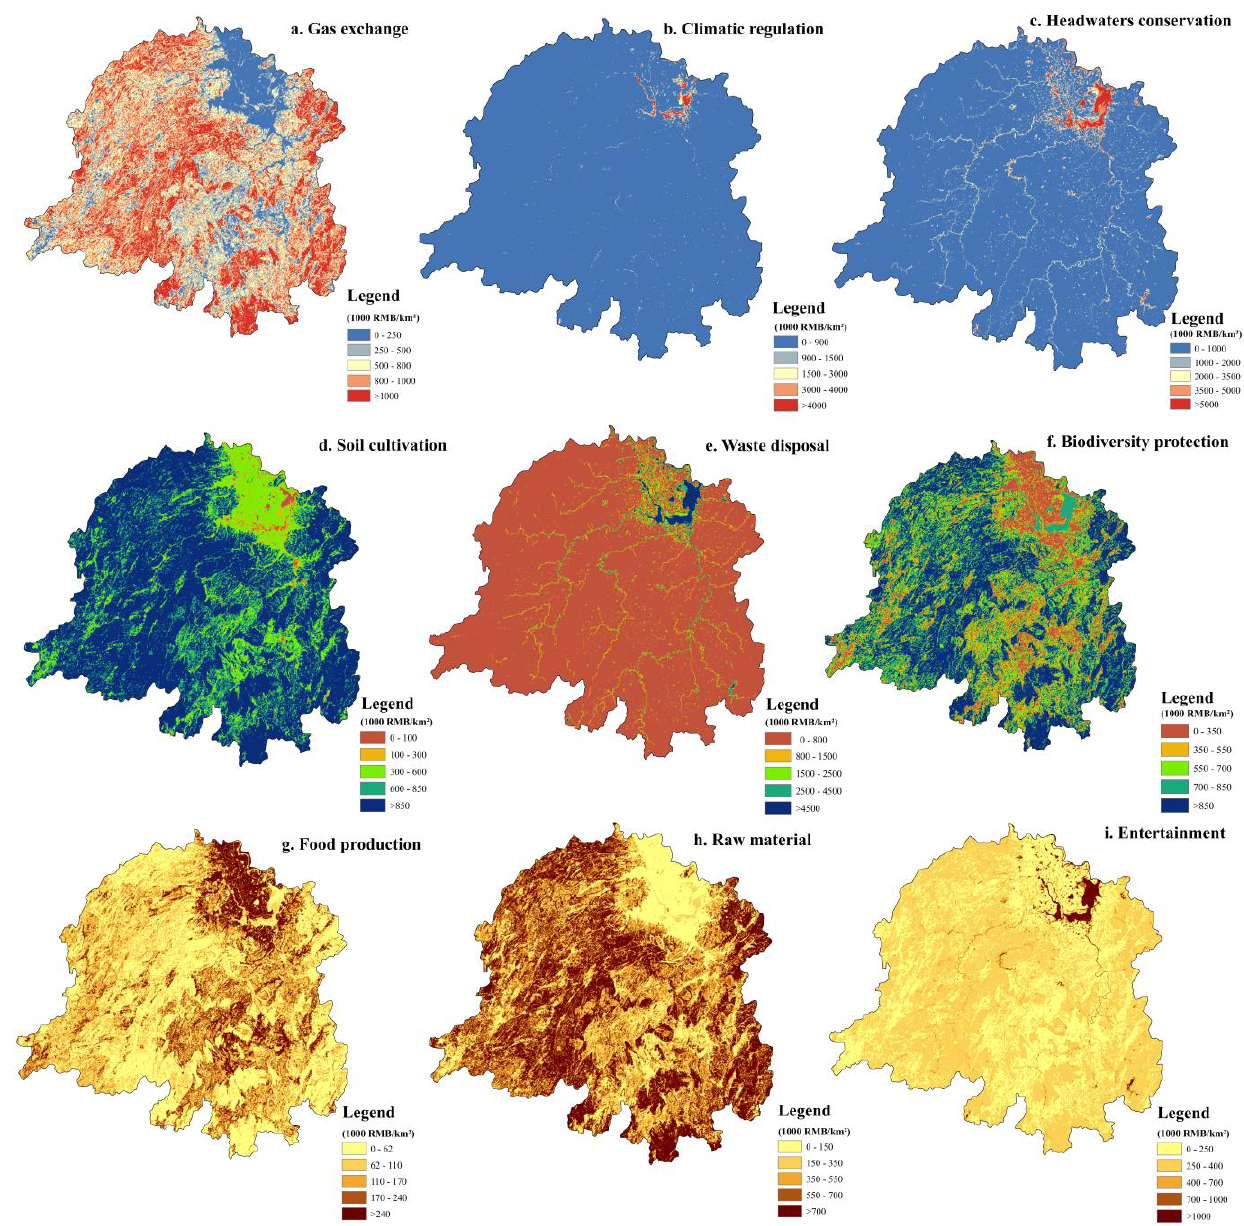
Figure 5. Spatial distribution of single ESVs in the Dongting Lake Basin.